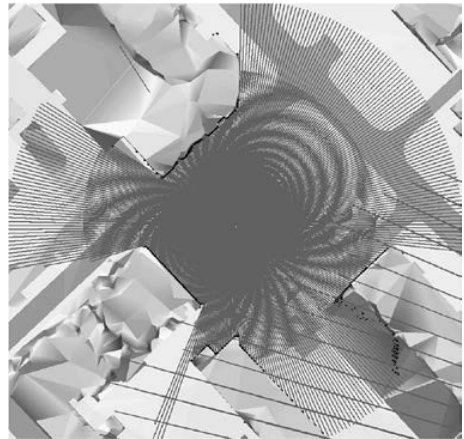
Fig. 7. Obstacles for ray